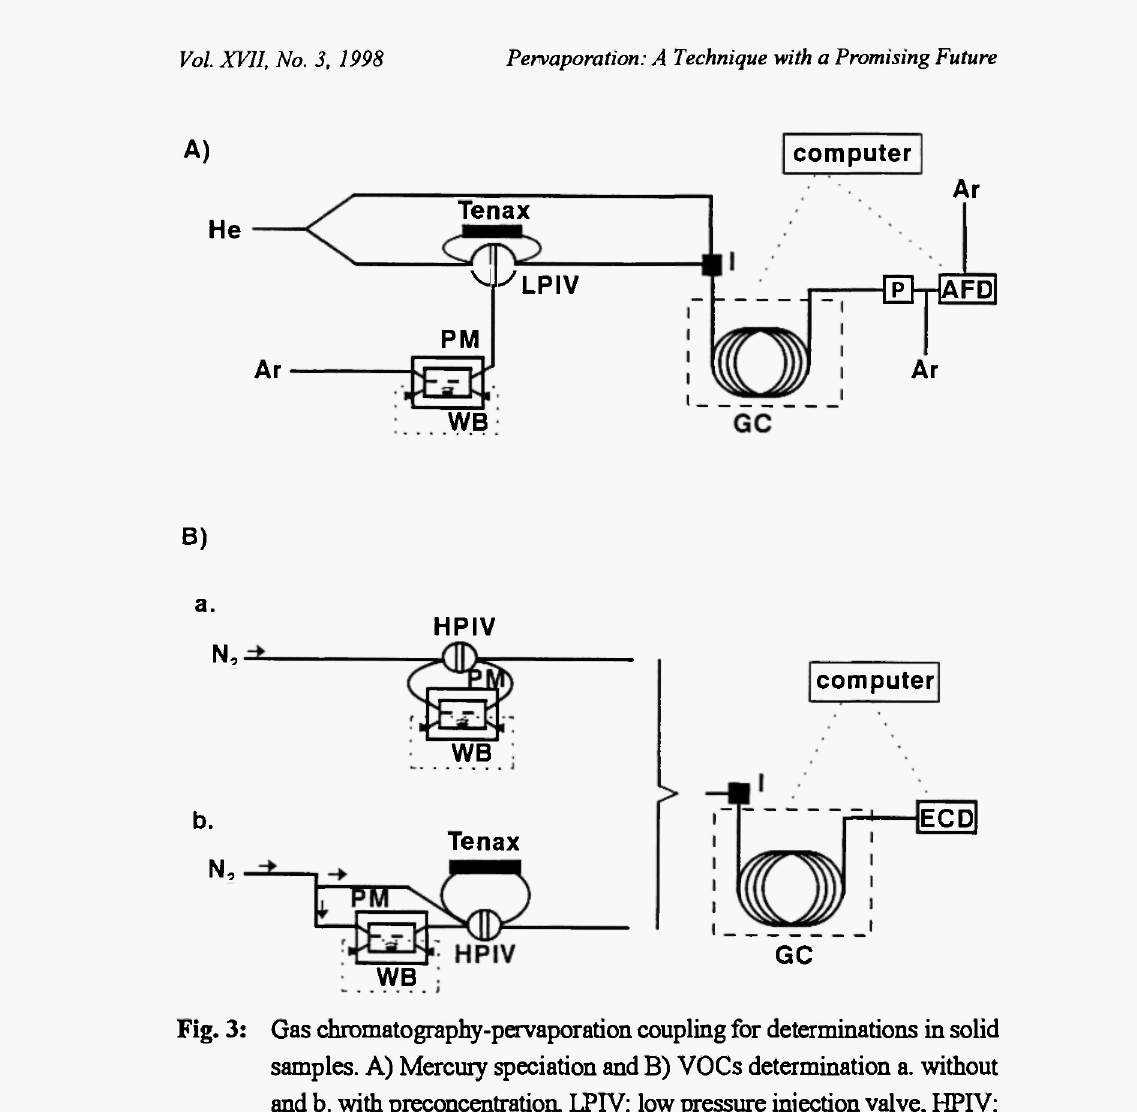
Fig. 3: Gas chromatography-pervaporation coupling for determinations in solid samples. A) Mercury speciation and B) VOCs determination a. without and b. with preconcentration LPIV: low pressure injection valve, HPIV: high pressure injection valve, I: injector (gas Chromatograph), GC: gas Chromatograph, Ρ: pyrolysis unit, AFD: atomic fluorescence detector, ECD: electron capture detector. Other abbreviations as in Fig.